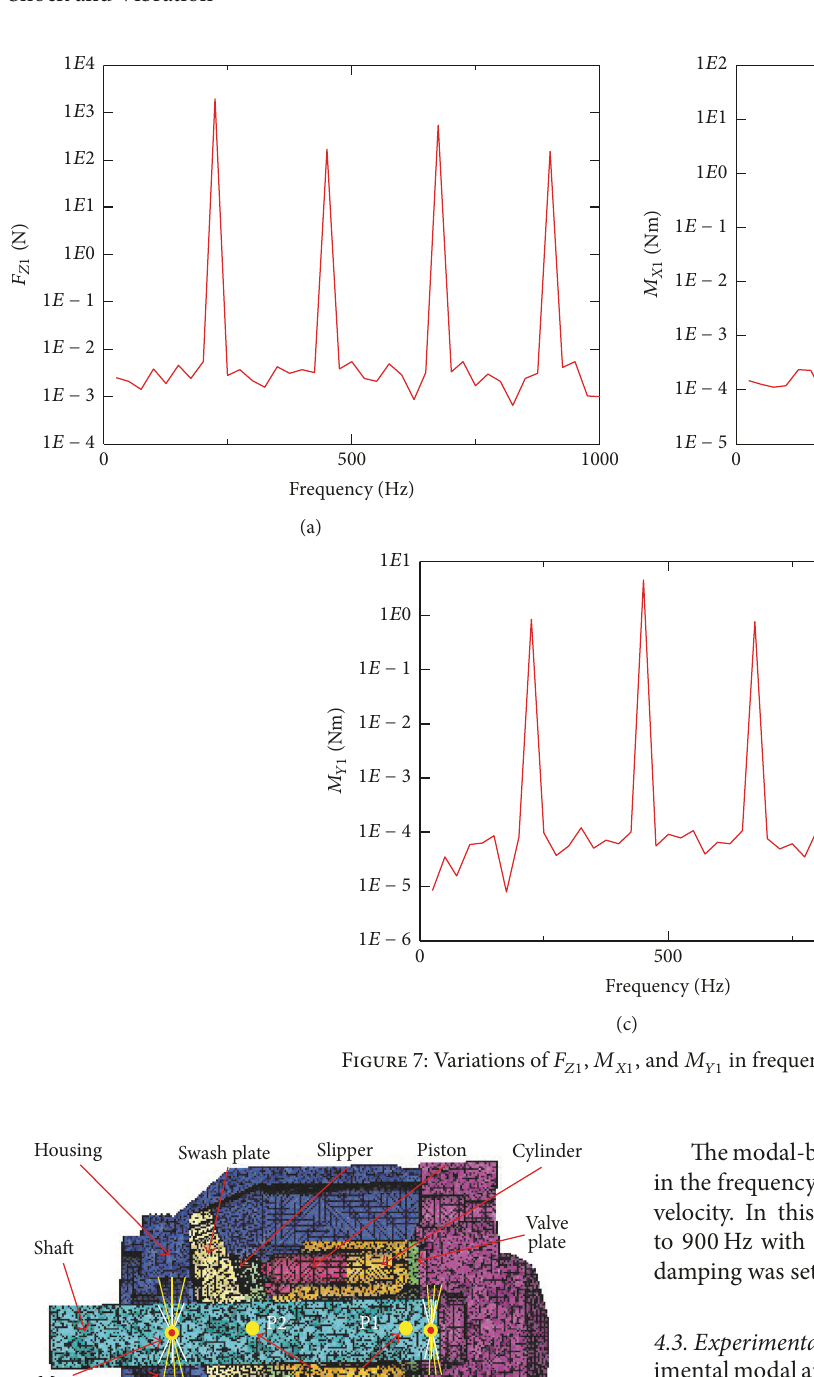
Figure 8: Structural finite element model of the axial piston pump.